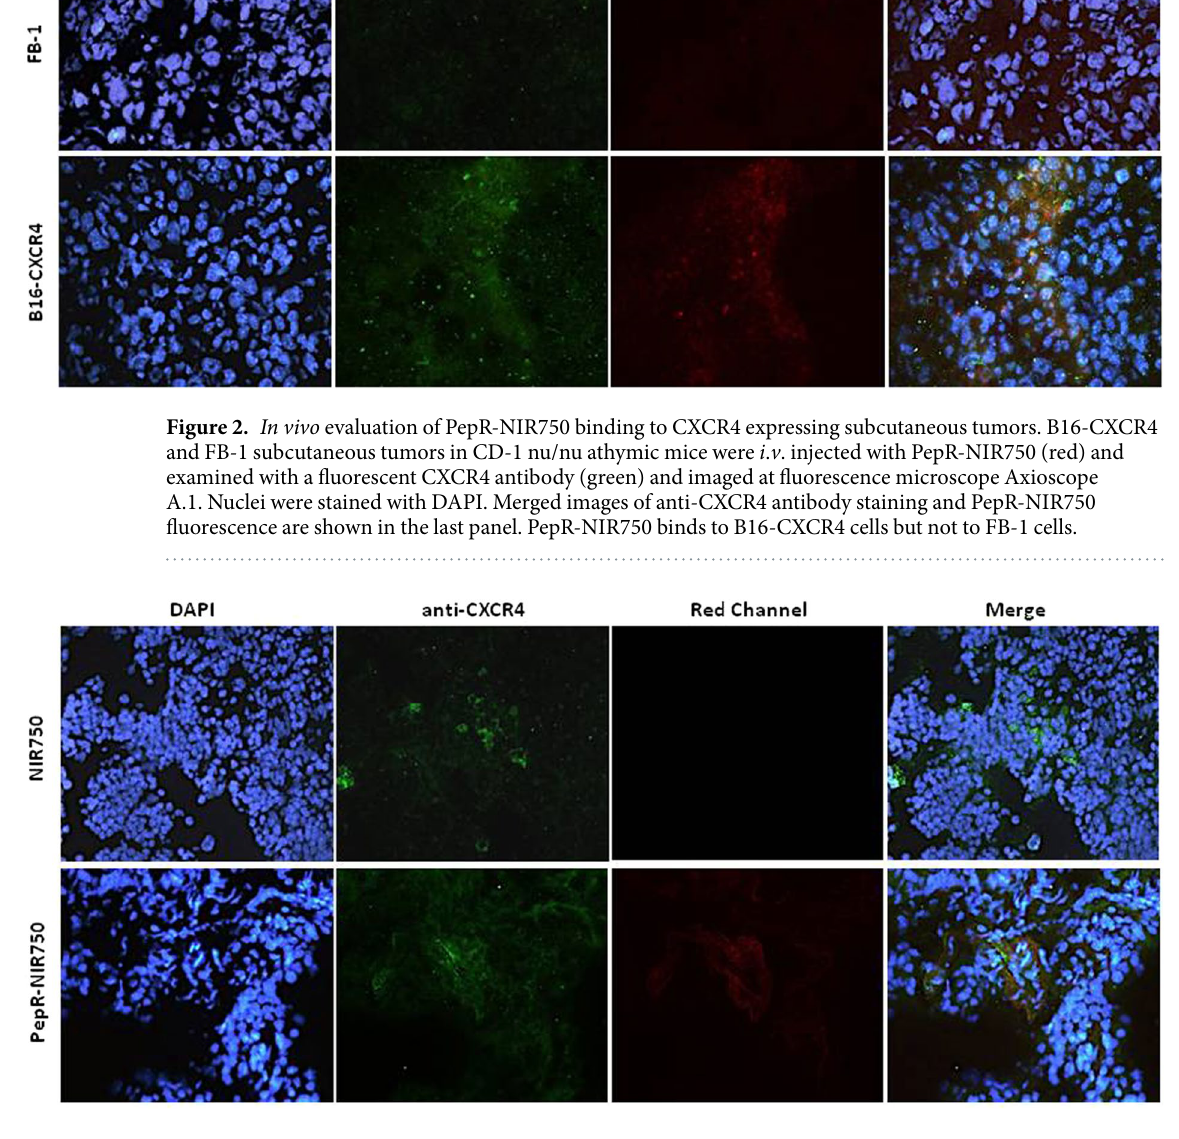
PepR-NIR750 signal (red) was detected in B16-CXCR4 tumors but not in FB-1 tumors. B16-CXCR4 and FB-1 tumors were respectively positive and negative for CXCR4 staining (green). CXCR4/AlexaFluor488 and PepR-NIR750 staining overlapped in B16-CXCR4 tumor sections confirming the same target for PepR-NIR750 and CXCR4/AlexaFluor488. In addition, B16-CXCR4 (350,000 cells/mice) were i . v . inoculated in 6 mice. Three weeks later the mice were injected with PepR-NIR750 and lung metastasis evaluated for specific PepR-NIR750 versus VivoTag-S 750 staining. As shown in Fig. 3 PepR-NIR750 (red) labelled B16-CXCR4 derived lung metas- tases and co-localized with CXCR4 (green) in metastatic cells. Control probe, VivoTag-S 750 did not label CXCR4-expressing metastatic cells. Thus PepR-NIR750 specifically binds to CXCR4-expressing cells in vivo .